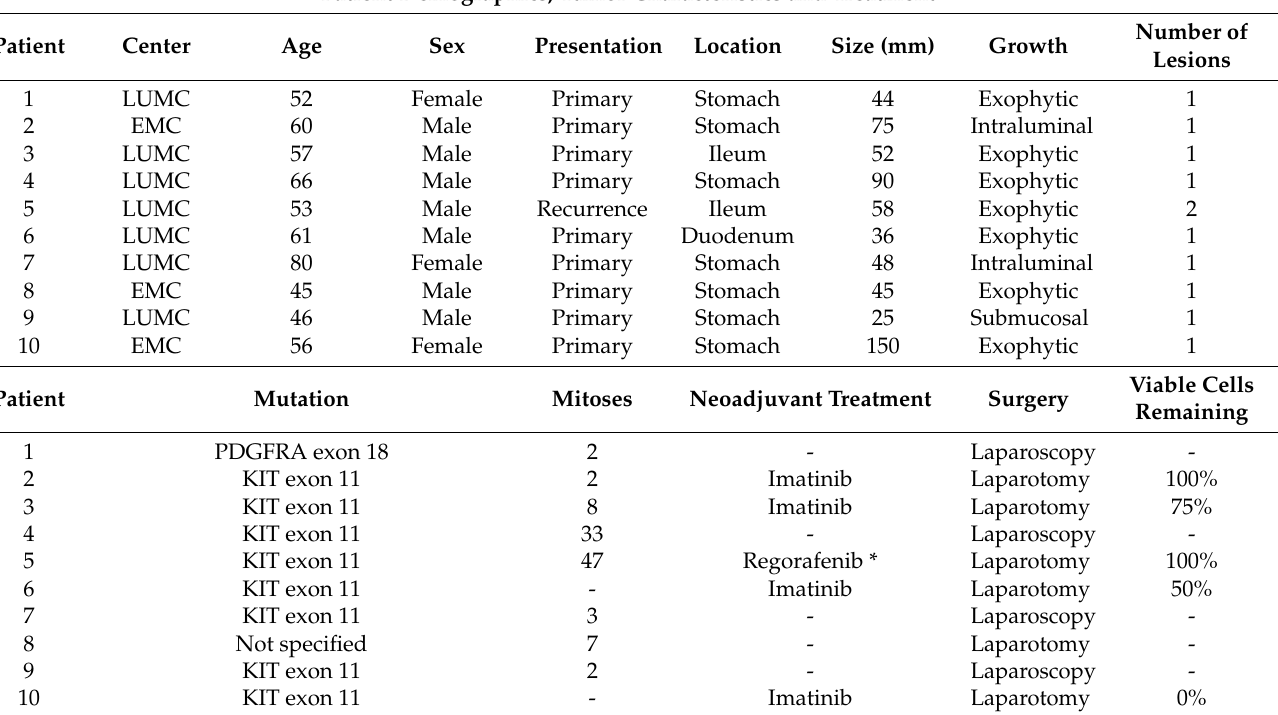
Table 1. Demographics, tumor characteristics, and treatments per patient. * Regorafenib after earlier courses of imatinib and